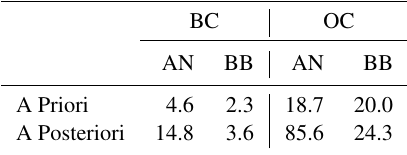
Table 2. Anthropogenic (AN) and biomass-burning (BB) emissions (unit: Tgyr − 1 ) of BC and OC in the year